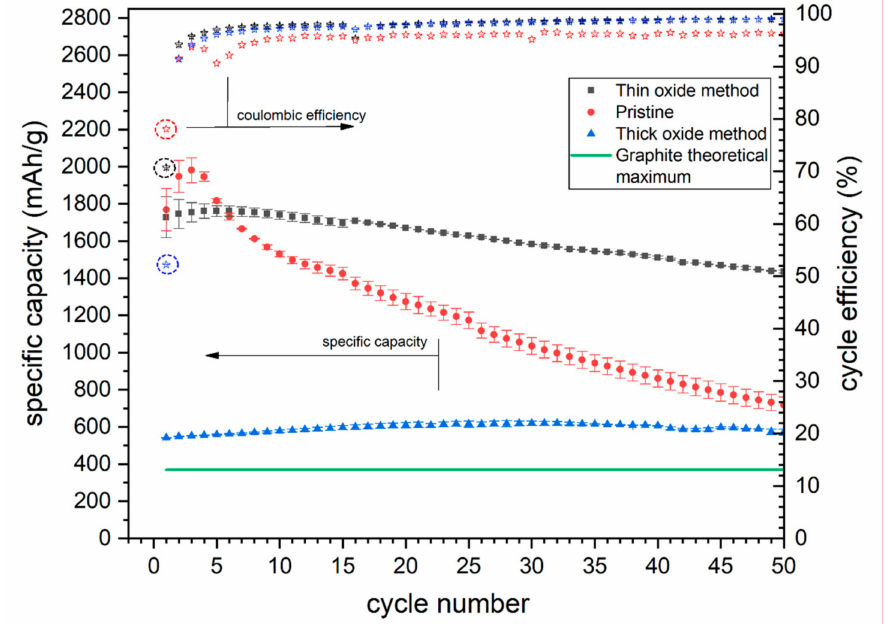
Figure 6. Pristine (red), Si-1 (black) and Si-2 (blue) galvanostatic charge / discharge results. Stars—coulombic e ffi ciency. Squares, circles and triangles—specific delithiation capacities. Green line—theoretical capacity of graphite (372 mAh /